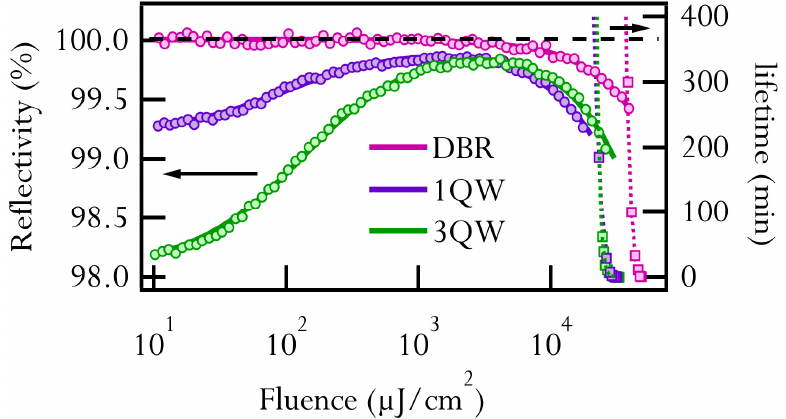
Figure 9. Nonlinear reflectivity and lifetime measurements for a (distributed Bragg reflector) (DBR), a SESAM with 1 QW as an absorber and a similar SESAM with 3 QWs as